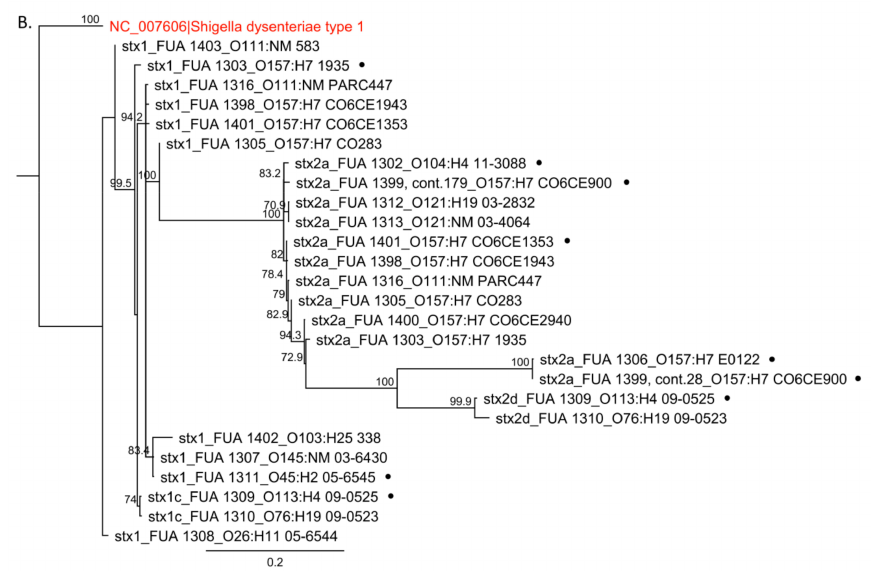
Figure 2. Phylogenetic tree analysis of the stx gene sequences and the DNA sequence of the corresponding p R’ fragments. The phylogenetic tree was based on 26 sequences from 17 STEC strains (Table 1). Neighbor-Joining trees were generated in Geneious using the Tamura–Nei model. The reliabilities of the internal branches were assessed using bootstrapping with 1000 pseudo-replicates. The scale bars represent the number of the substitution per site. Bootstrap values over 70% are displayed. Shigella dysenteriea type 1 strain Sd197 was included as the outgroup. Strains that had significant phylogenetic differences between the p R’ region and stx gene are highlighted by dots and were used in downstream studies. ( A ) Phylogenetic tree generated by comparing the stx genes, which included both subunit A and B. ( B ) Phylogenetic tree generated by aligning the p R’ region located between Q and stx . Viruses 2018 , 10 , x FOR PEER REVIEW